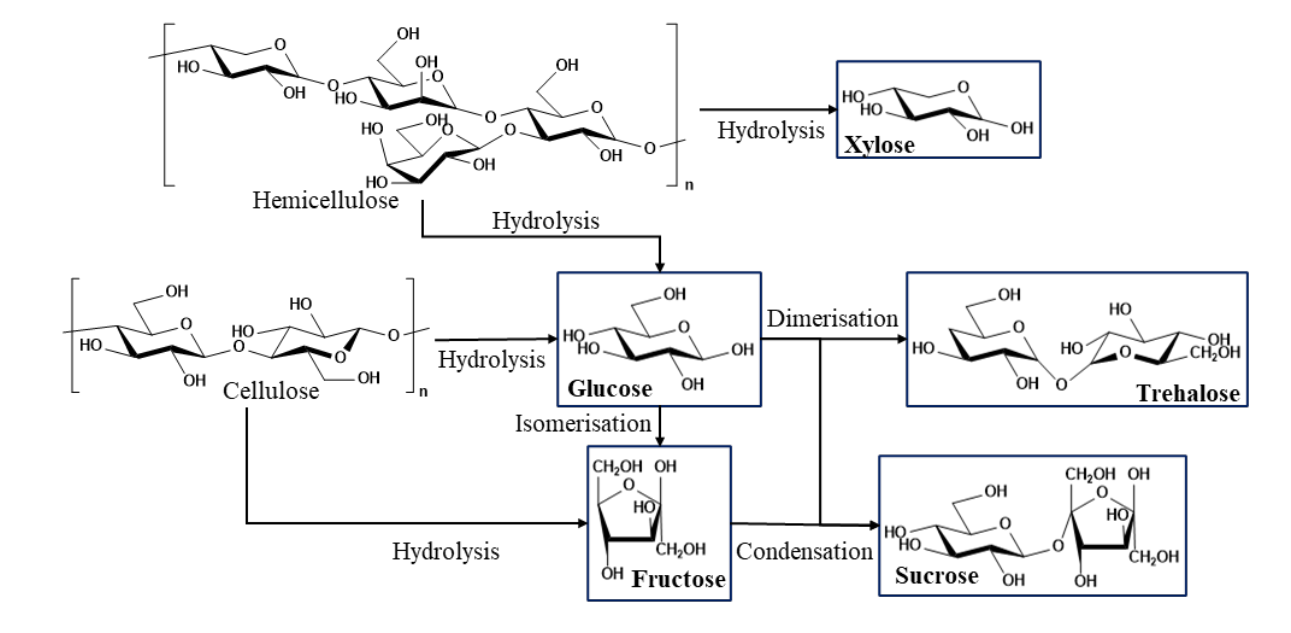
Figure 3. Scheme of monosaccharide and disaccharide formation from holocellulose. Table 3. Calibration data used for HPLC-RID quantification of sugars from thermochemical liquefac- tion of Eucalyptus globulus